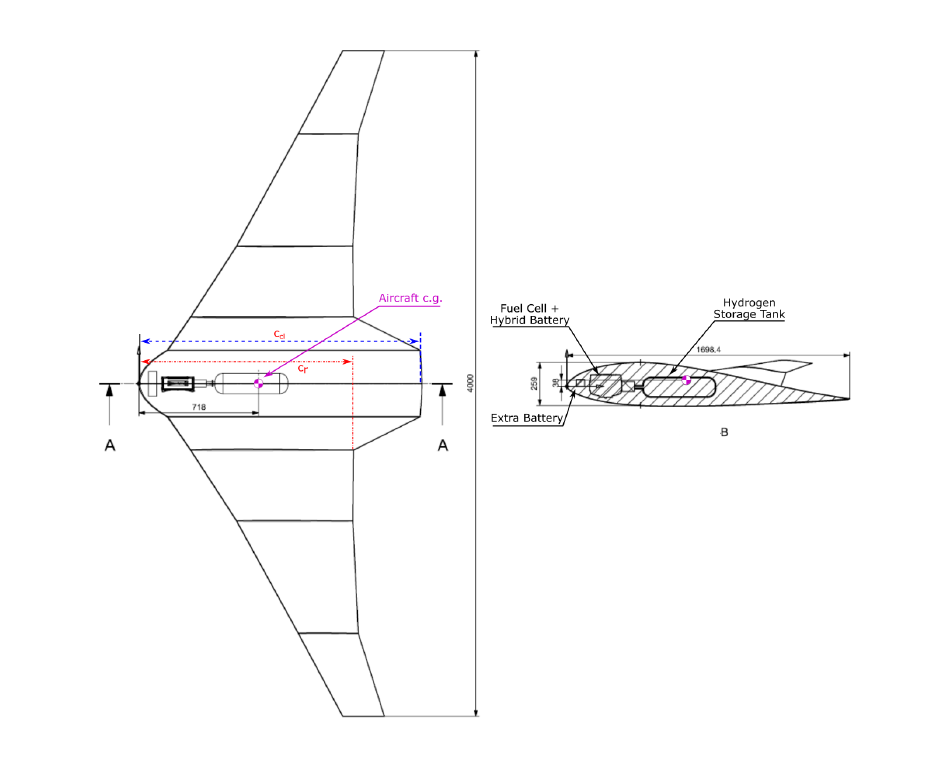
Figure 4. Aircraft Dimensions. All dimensions are in